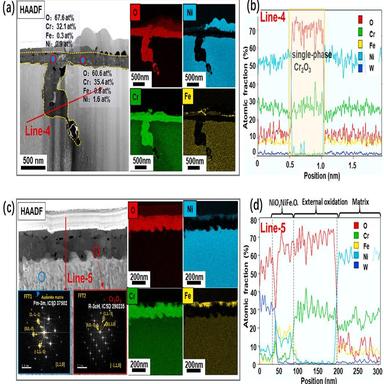
(a) HAADF image and the O, Ni, Cr, Fe element EDS mapping results of the oxide scale formed at the GB (Region A in Fig. 9) after exposure in SCW at 600 ◦C for 1000 h, illustrating a multi-layer oxide scale, (b) EDS line scan (Line scan 4) across the preferentially oxidized GB, (c) the TEM HAADF and the O, Ni, Cr, Fe element EDS mapping results of the thin oxide scale (Region B in Fig. 9), (d) EDS line scan (Line scan 5) across the thin oxide scale.